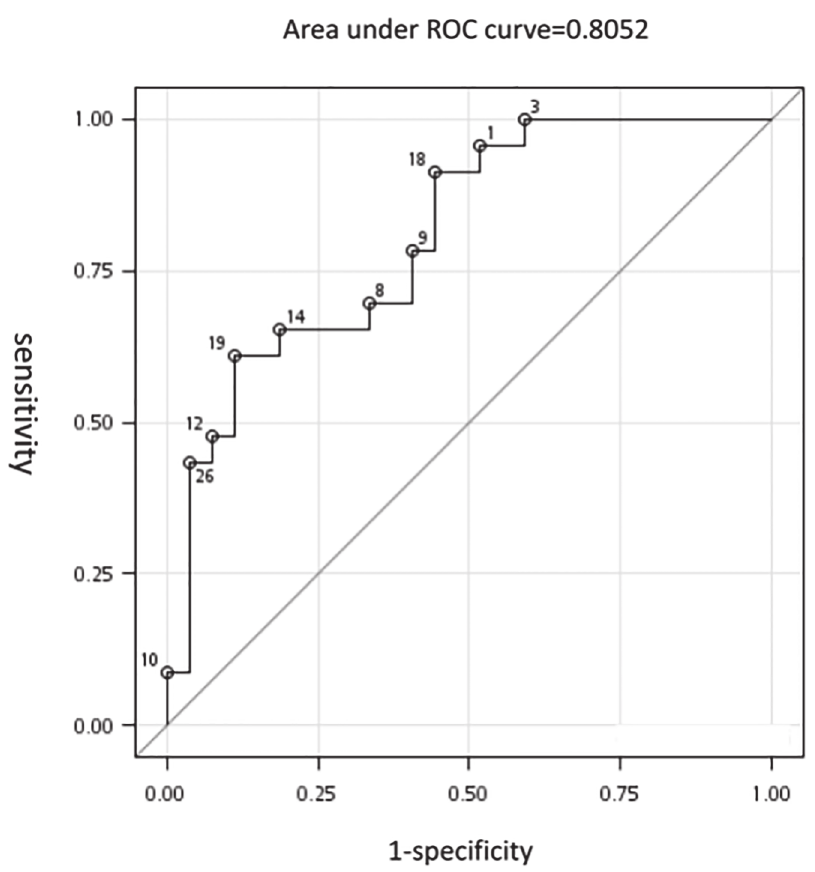
Fig 1. The ROC curve of nodal width for predicting HBeAg seroconversion in chronic B hepatitis with acute flare. The area under curve is 0.8052.